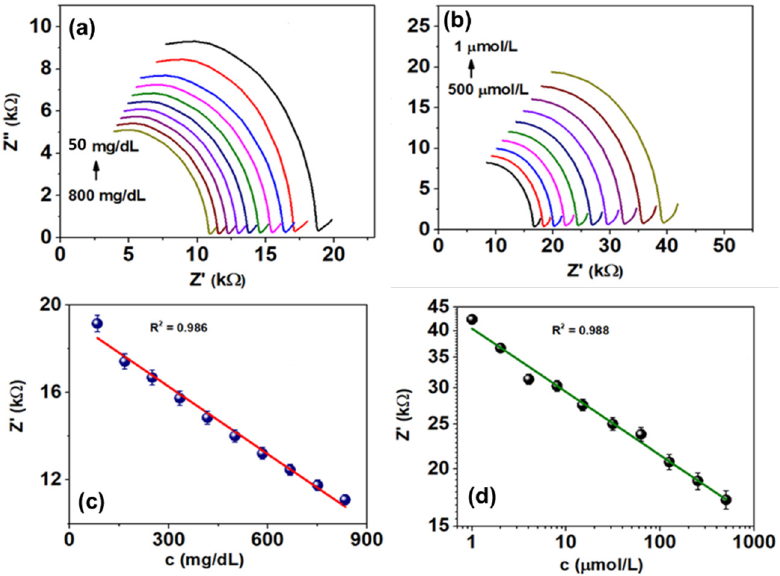
Figure 4. Nyquist spectra obtained from electrocatalytic sensing of ( a ) glucose within 50–800 mg/dL; ( b ) tyrosine within 1–500 µmol/L and sensor calibration at 10 kHz for ( c ) glucose; ( d ) tyrosine monitoring.